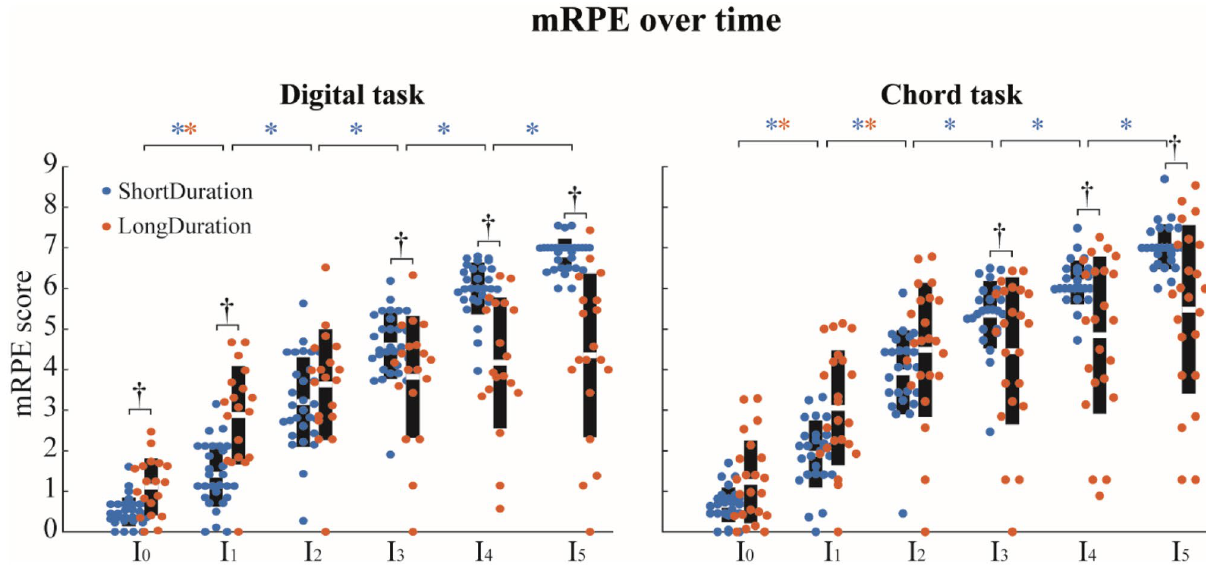
Figure 2. Mean ± standard deviation of mRPE score for each interval for the Digital task (left panel) and the Chord task (right panel). White horizontal lines represent the mean mRPE score for each group, black boxes represent the standard deviation, and dots represent each participants’ data. Blue and red asterisks represents significant differences between successive intervals for the ShortDuration and LongDuration group, respectively. † Significant differences between groups (α =